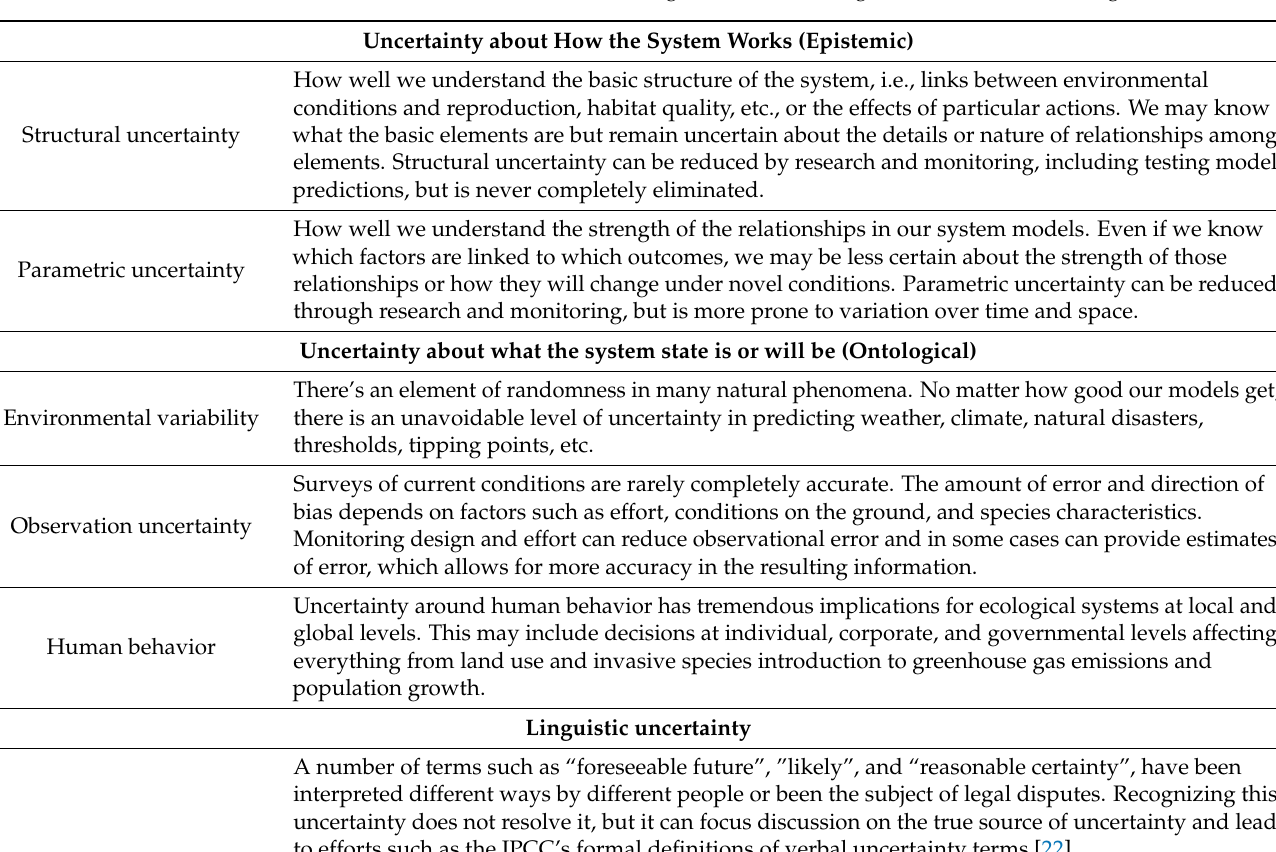
Table 1. Types of uncertainty related to ecological systems pertinent to wildlife managers. Uncertainty related to climate models falls primarily into the structural and parametric categories. Uncertainty